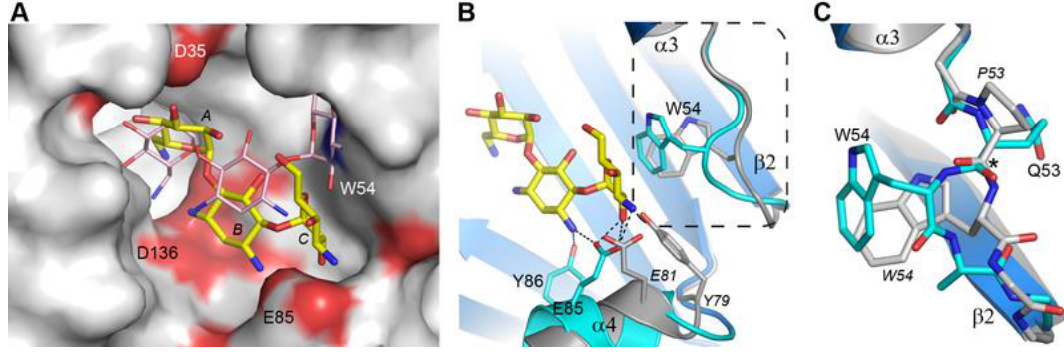
FIGURE 4: Structural comparison of AAC(6’)-Im and AAC(6’)-Ie. (A) Molecular surface representation of the binding site of AAC(6’)-Im (grey, red and blue shading). The kanamycin A molecule in AAC(6’)-Im binding site is shown as yellow sticks and the kanamycin A molecule in AAC(6’)-Ie is shown as thin pink sticks. (B) Ribbon representation of the loop between helix α3 and strand β2 shown in cyan for AAC(6’)-Im and grey for AAC(6’)-Ie. The location of the Trp54 side chain is indicated for both enzymes. The kanamycin A molecule in AAC(6’)-Im is shown as yellow sticks. The dashed box shows the area represented in panel C. (C) Close up view of the conformational difference caused by the presence of Pro53 in AAC(6’)-Ie (grey) relative to a Gln53 in AAC(6’)-Im (cyan). The difference in orientation of the residue 53 carbonyl group is indicated by the asterisk. Residues from AAC(6”)-Ie are labeled in